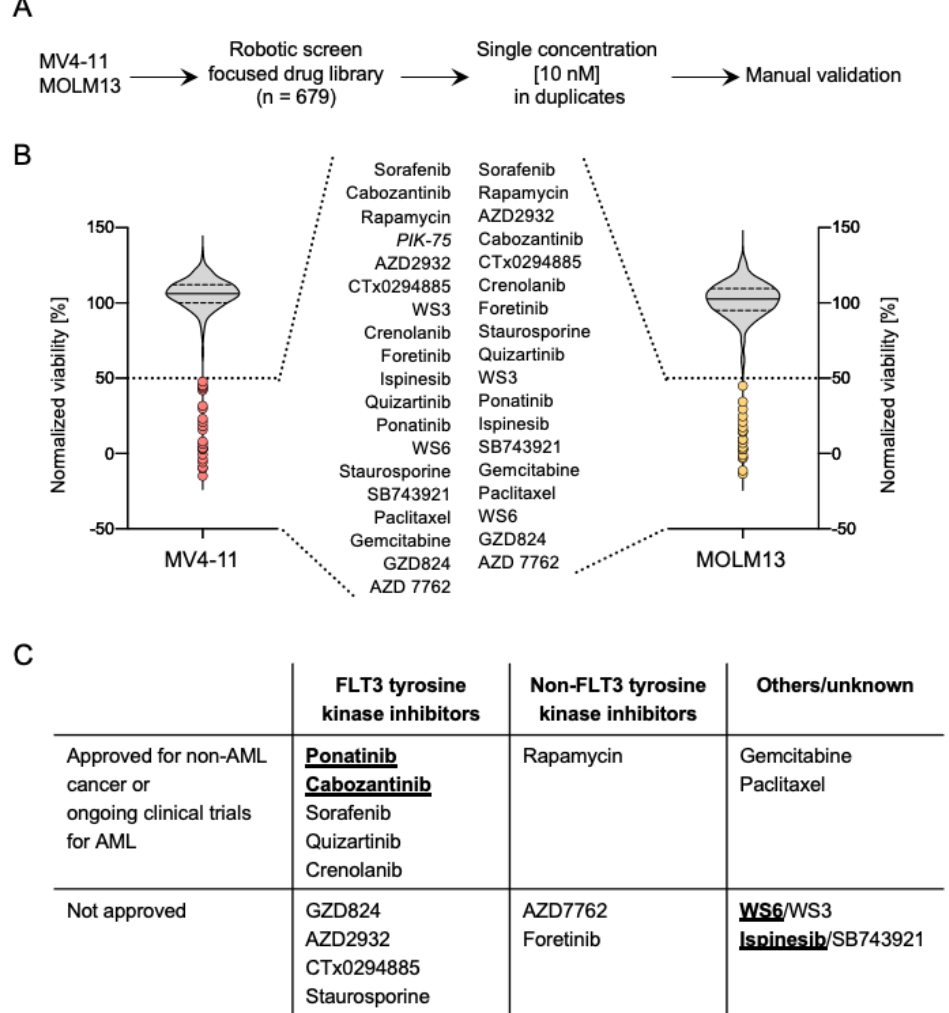
Figure 1. A high-throughput screen using a 679 small molecule inhibitor library. ( A ) Illustration of the applied screening procedure. Cell viability was measured after 72 h of treatment using CellTiter-Glo ® (Promega). ( B ) Violin plots showing the effect of the drugs on the viability of MV4-11 and MOLM13. Drugs that reduced the viability below 50% are depicted in red (MV4-11) or yellow (MOLM13) and are listed according to their effect from lowest (top) to the highest (bottom). Drug (PIK-75) that induced decreased viability only in MV4-11 shown in italics. ( C ) Discovered hits separated according to their clinical use status and the known mechanism of action. Drugs investigated further shown in underlined bold.